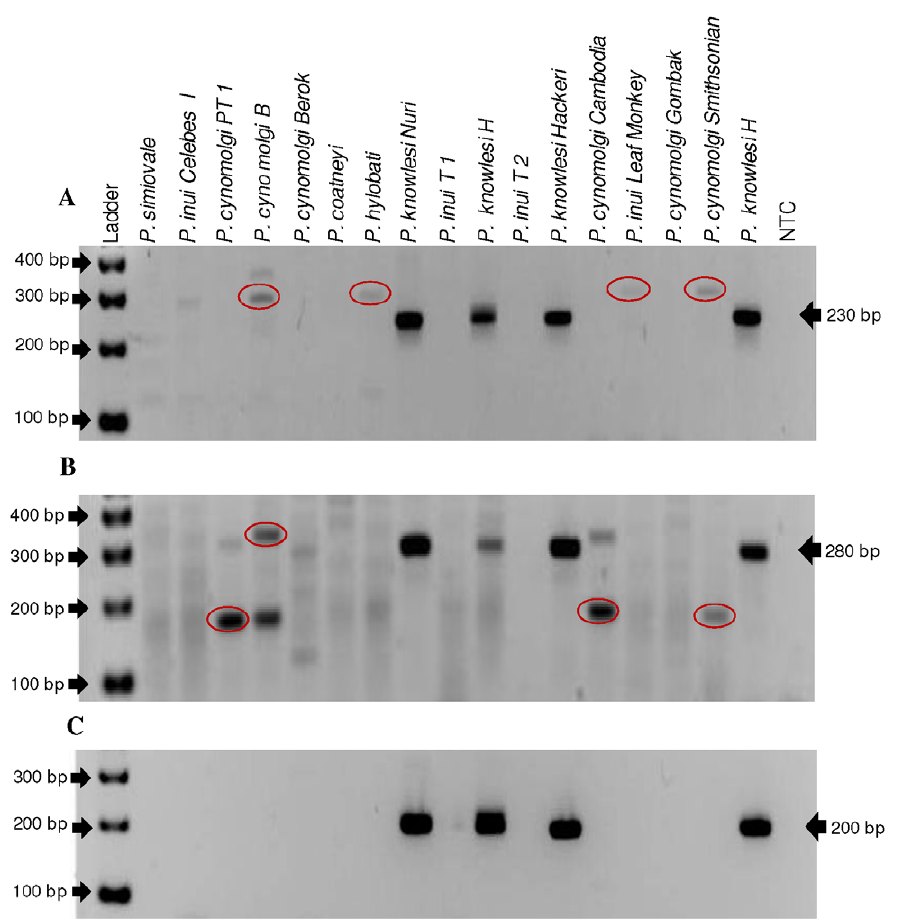
Characteristics of Pkr140 The Pkr140 sequence repeats are present in 7 copies distributed across 6 chromosomes (Figure 6). Six of the copies